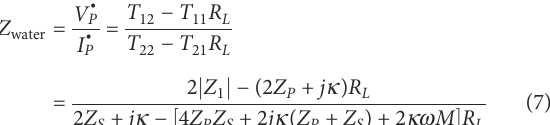
FIGURE 2 A two-port network model of the equivalent mutual inductance model of CLPT system in